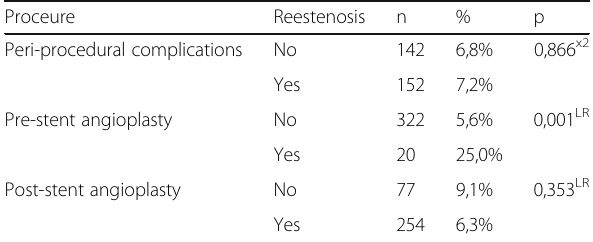
Table 5 The influence of procedural characteristics on restenosis Proceure Reestenosis Peri-procedural complications